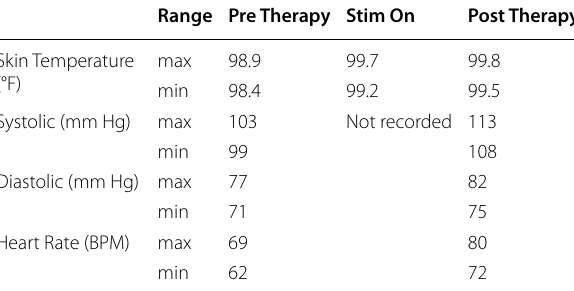
Table 2 Changes in skin temperature and cardiovascular function before and after